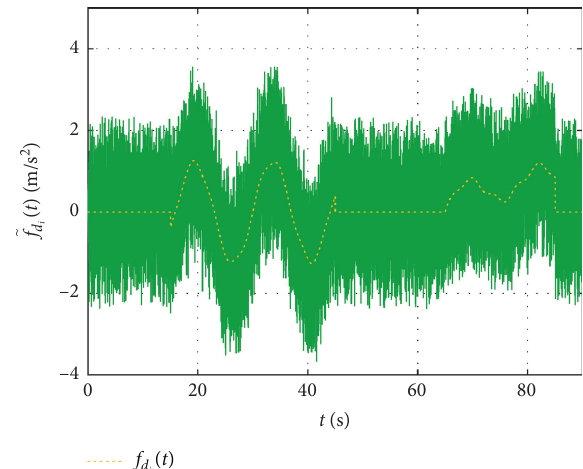
Figure 14: Acceleration disturbances induced by high-frequency